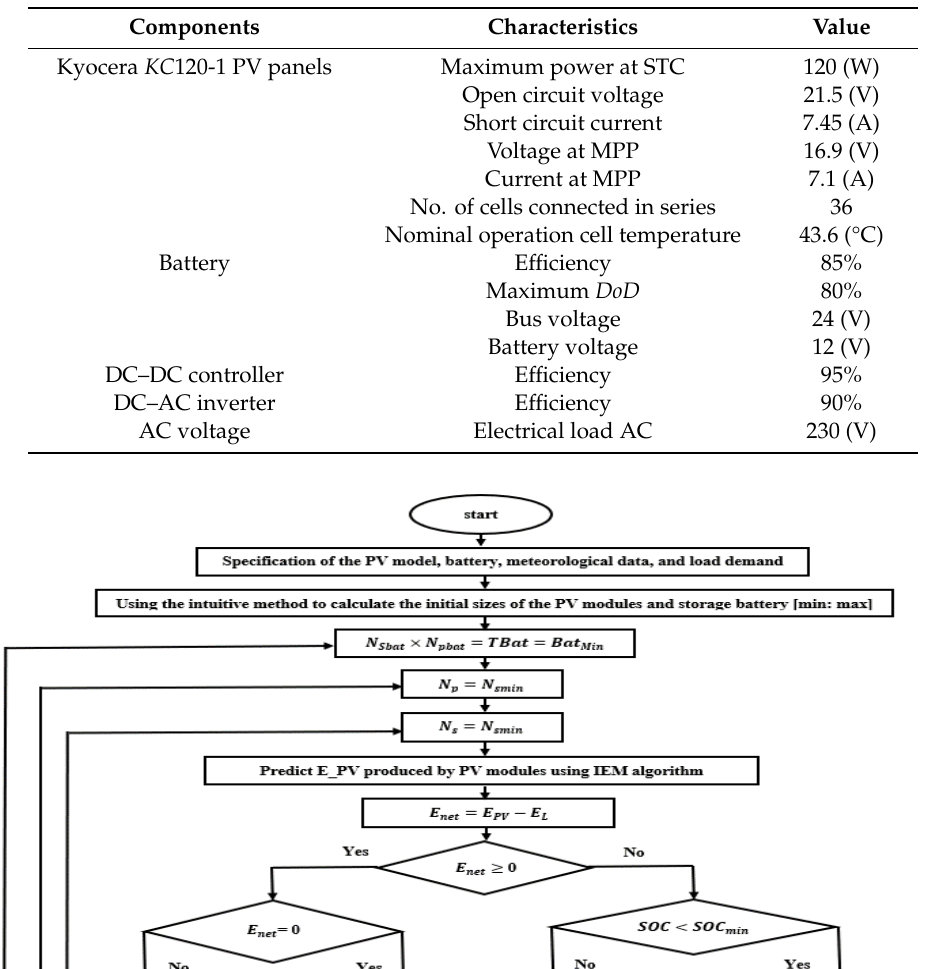
Table 3. C omponents’ specifications of the standalone PV system. Table 3. Components’ specifications of the standalone PV system.